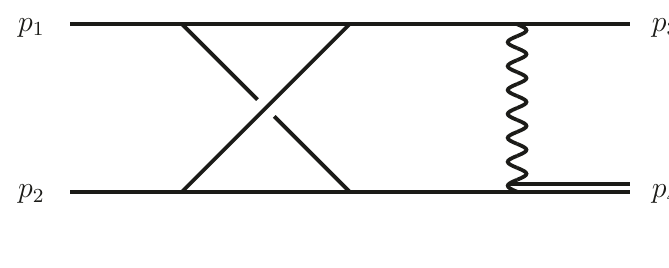
Figure 2 . Two loop graph of the non-planar topology